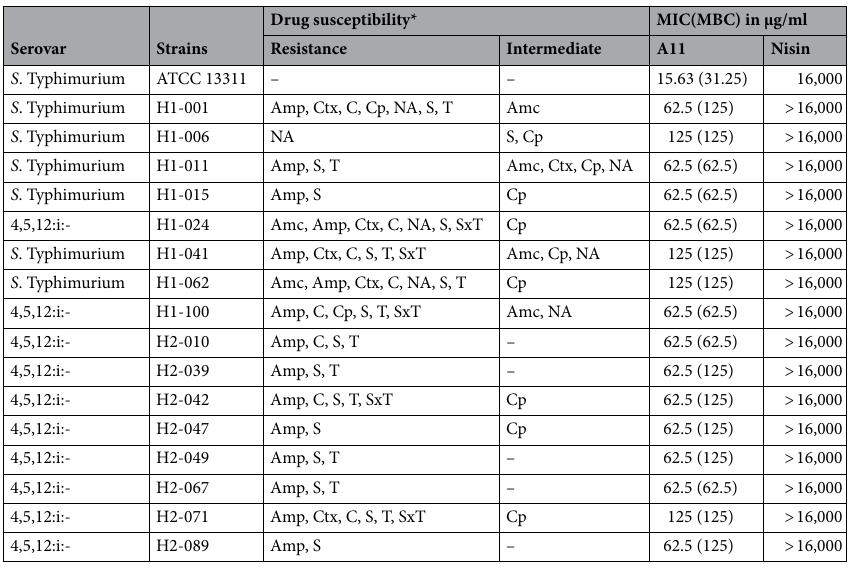
Table 3. Minimum inhibitory concentration (MIC) and minimum bactericidal concentration (MBC) of A11 against 16 drug-resistant Salmonella enterica strains. All strains were grown in Tryptic Soy Agar (TSA). Amc amoxicillin/clavulinic acid, Amp ampicillin, Ctx cefotaxime, C chloramphenicol, Cp ciprofloxacin, NA nalidixic acid, Nor norfloxacin, S streptomycin, T tetracycline, SxT sulfamethoxazole/trimethoprim. *In vitro drug susceptibility of all isolates was performed using Kirby-Bauer disk diffusion test, in accordance with the standard procedure recommended by the Clinical and Laboratory Standards Institute (CLSI), and interpreted as susceptible, resistant, or intermediate according to interpretative criteria based on CLSI breakpoints 29 . The data were taken from Huoy, Pornruangwong, Pulsrikarn, and Chaturongakul (2014).